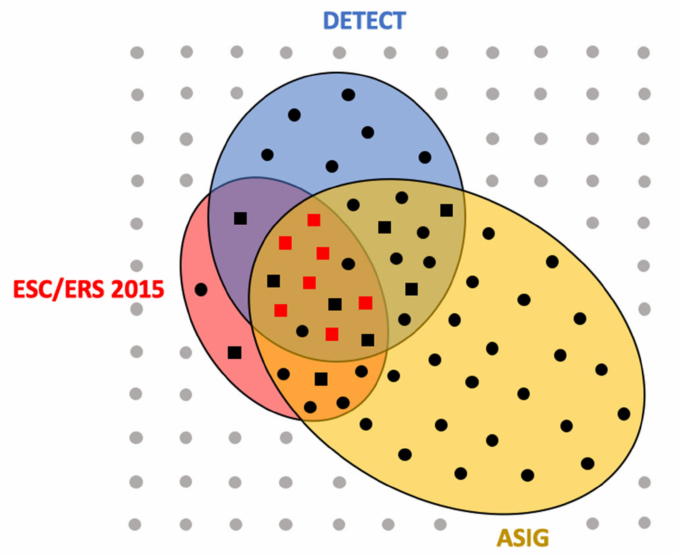
Figure 3. Representation of right heart catheterization indications according to the three algorithms and the multidisciplinary team